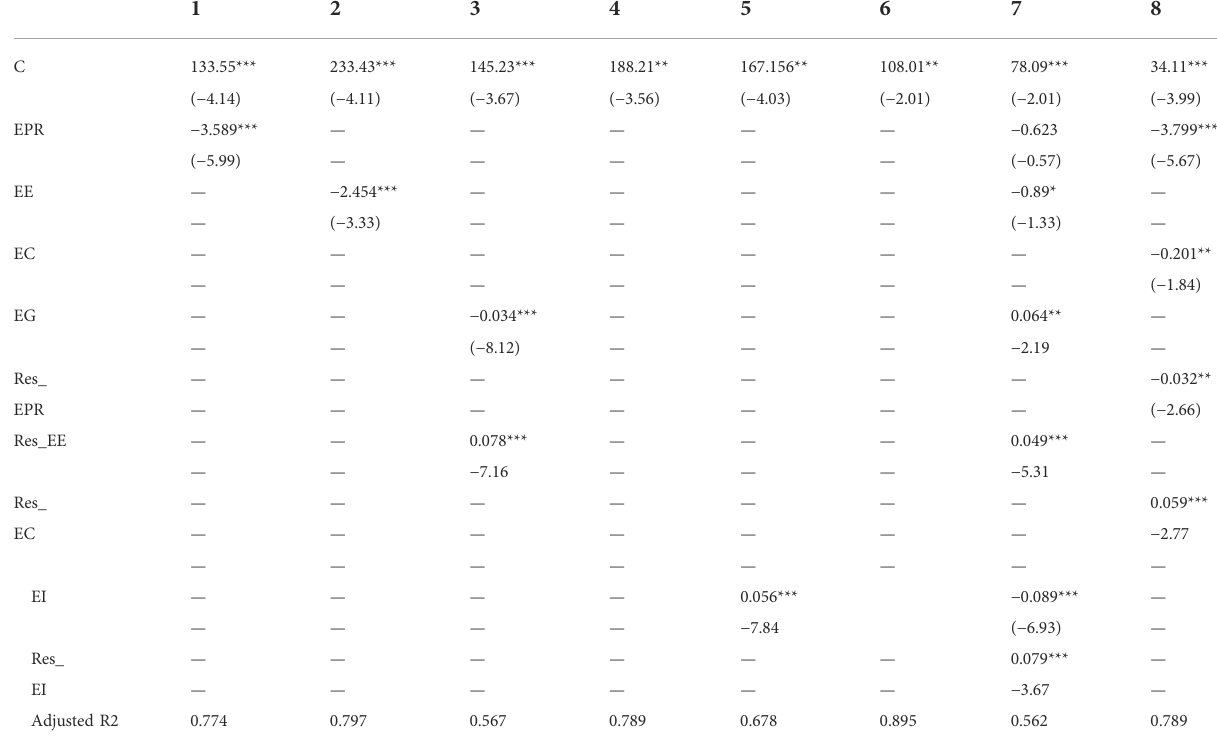
TABLE 5 Robustness